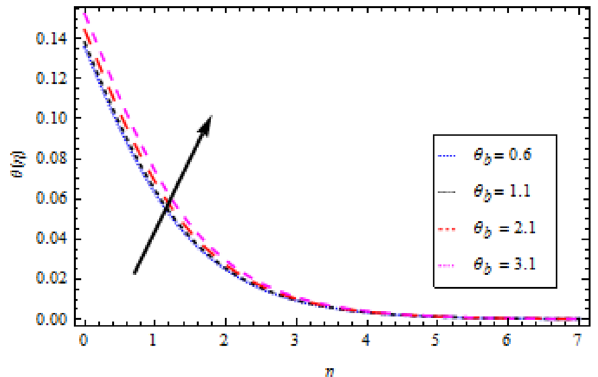
Figure 10. Temperature profile variation with respect to θ b .